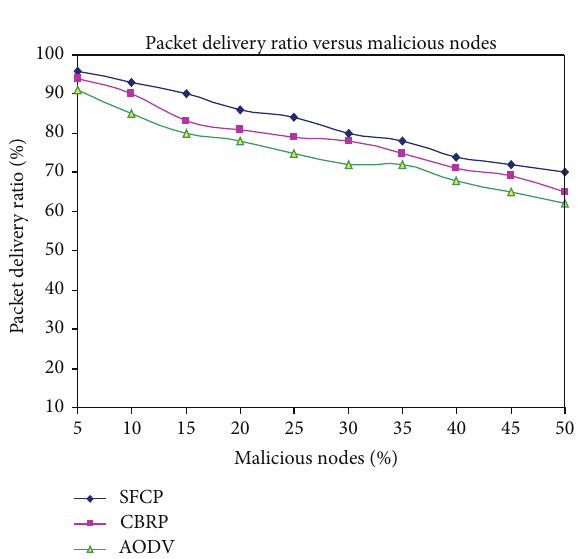
Figure 2: Packet delivery ratio versus malicious nodes.